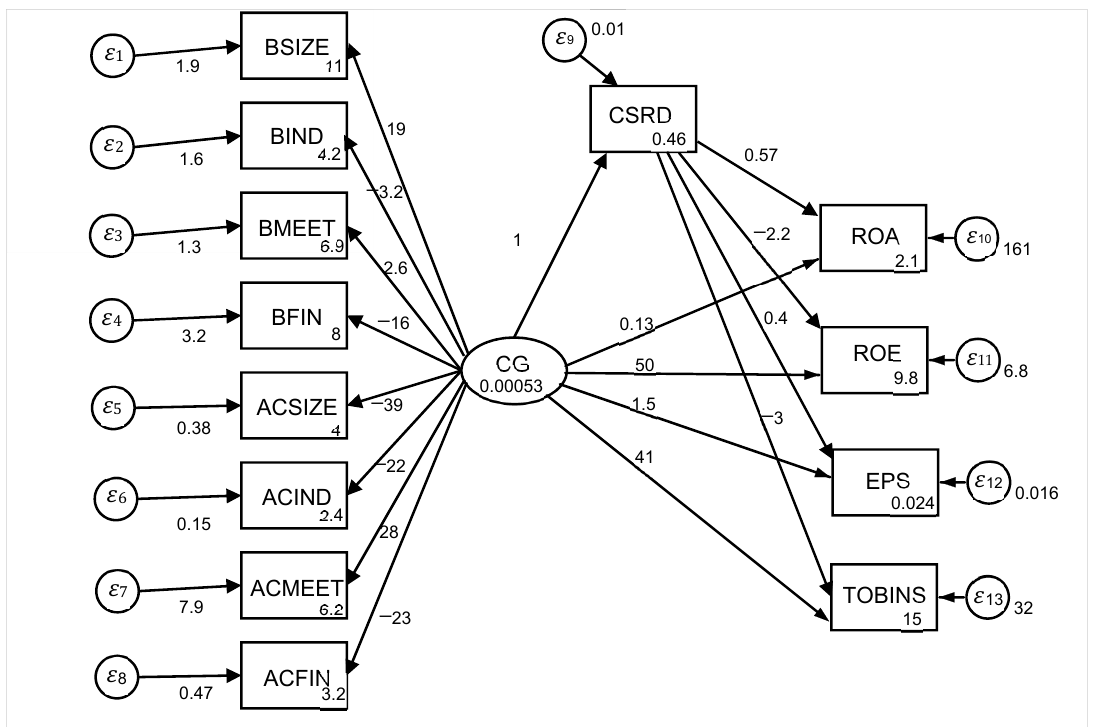
Figure 4. Result of mediating role of corporate social responsibility disclosure between corporate governance and bank performance.